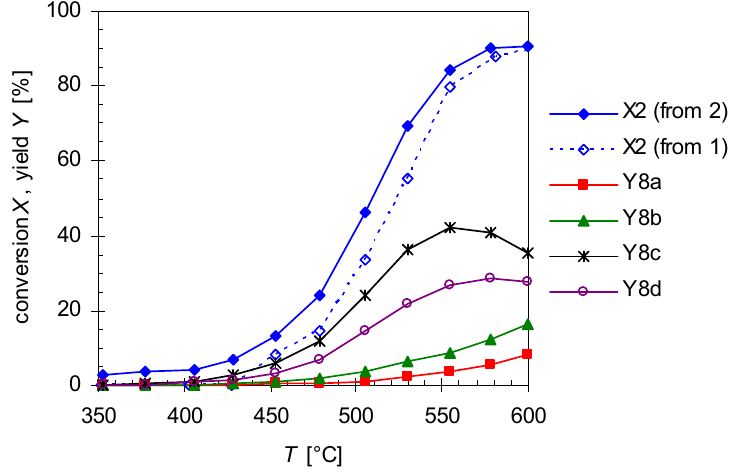
Figure 8. Temperature dependency of the linalool conversion X experiments with 1 (dotted line, open diamonds) and from experiments with 2 (solid line, closed diamonds) and the yields of plinols 8a – d ( Y with linalool 2 . Reaction conditions: 30 µL starting material, carrier gas N 0.8 L min − 1 , τ : 0.6–0.8